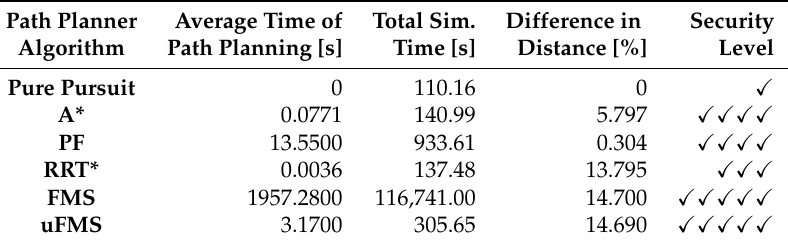
Figure 12. Comparison visualization of A* and FMS/uFMS planned paths. Table 3. Methods comparison.